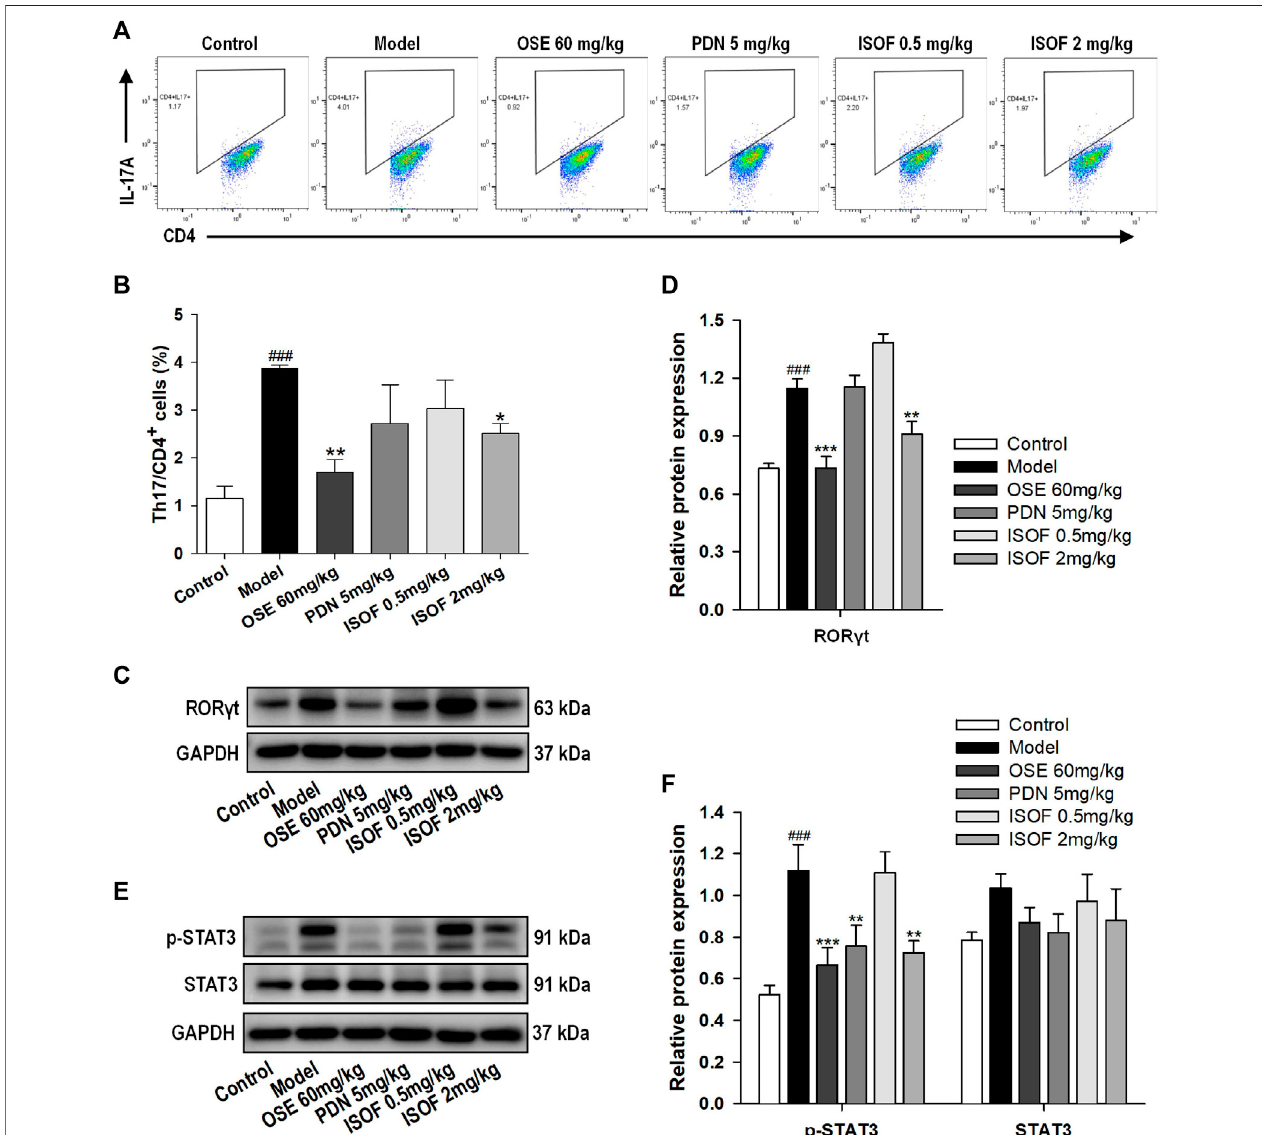
FIGURE 6 | ISOF reduced Th17 cells and the protein levels of ROR γ t and p-STAT3 in the lung tissues ofAECOPD model mice. (A) Representative fl ow cytometric dot-plots of Th17 cells in the lung tissues ofeach group (Th17: CD4 + IL-17A + cells). (B) The proportion of Th17 cells was analyzed. (C) The protein levels of ROR γ t in the lungtissuesofeachgroupwereassessedbywesternblot. (D) TherelativedensityofROR γ ttoGAPDHineachgroup. (E) TheproteinlevelsofSTAT3andp-STAT3inthe lung tissuesofeach groupwereassessedbywesternblot. (F) Therelative densityofSTAT3orp-STAT3toGAPDHineach group.Dataareexpressed asmeans ± SEM ( n (cid:1) 4 in each group). ### p < 0.001 vs. control group; * p < 0.05, ** p < 0.01, and *** p < 0.001 vs. model group.